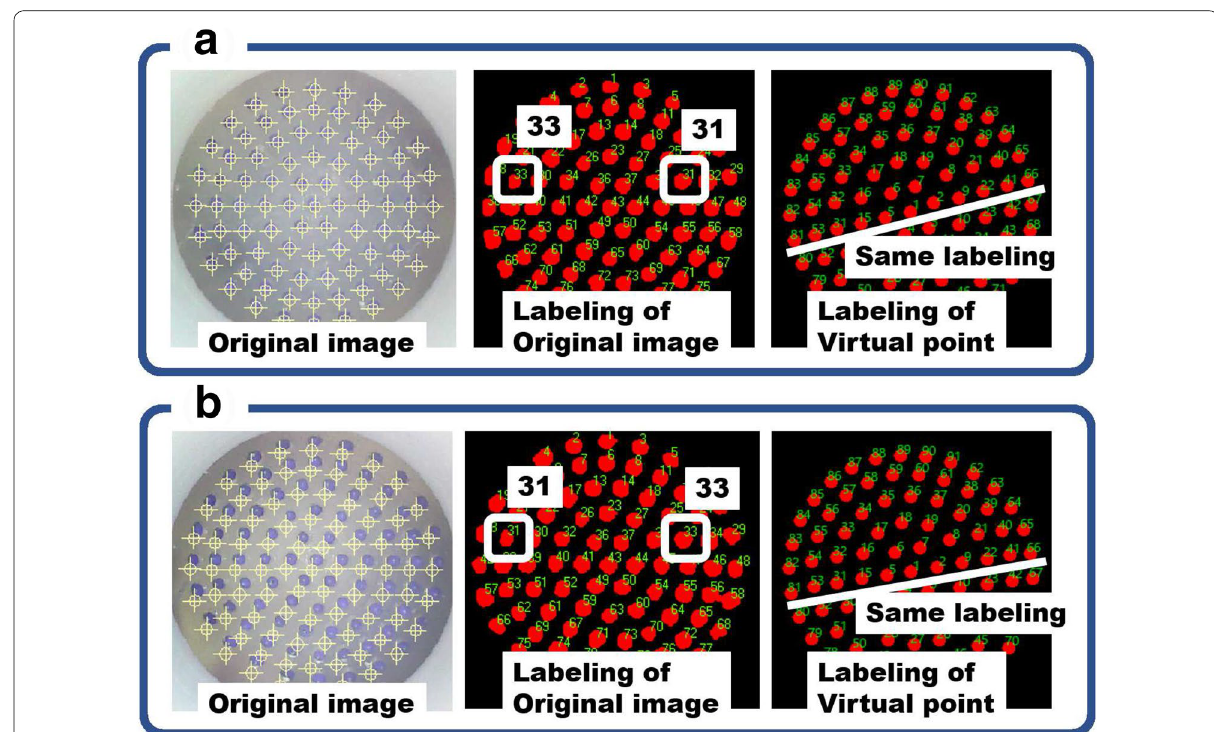
Fig. 4 Labeling by external forces and virtual points: a In case there is no deformation by the external force. b In case there is some deformation by the external force. Deformation by external forces may change the labeling order of observed points. However, it is possible to maintain the labeling order by using virtual